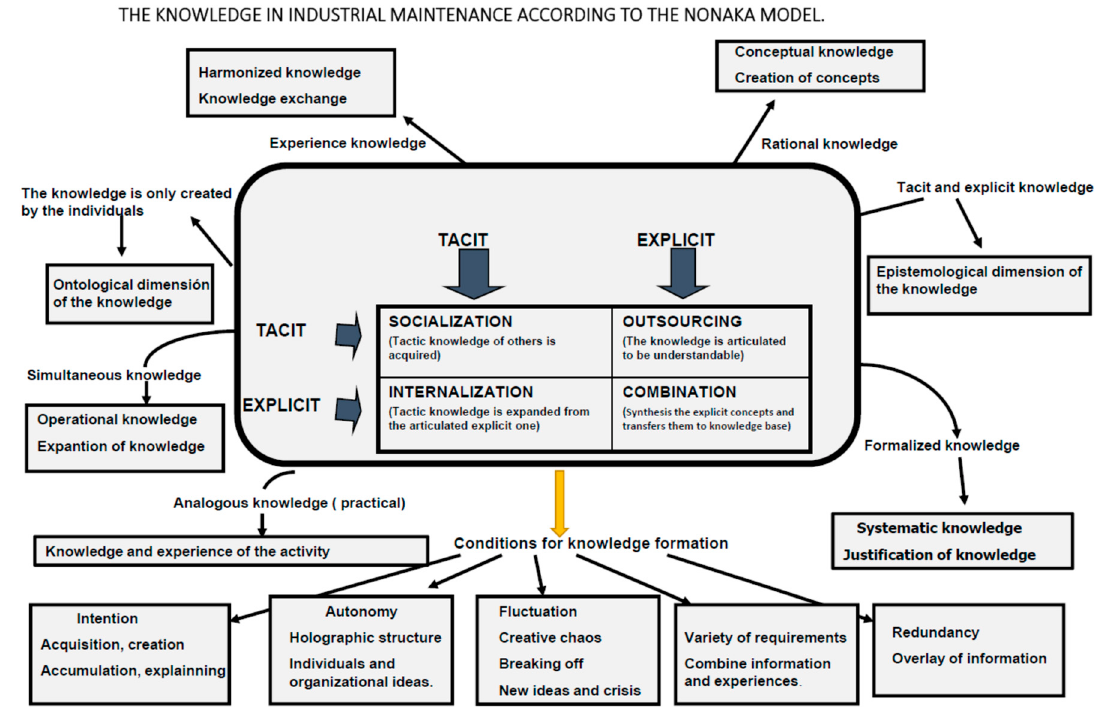
Figure 2. Industrial knowledge according to the Nonaka model.